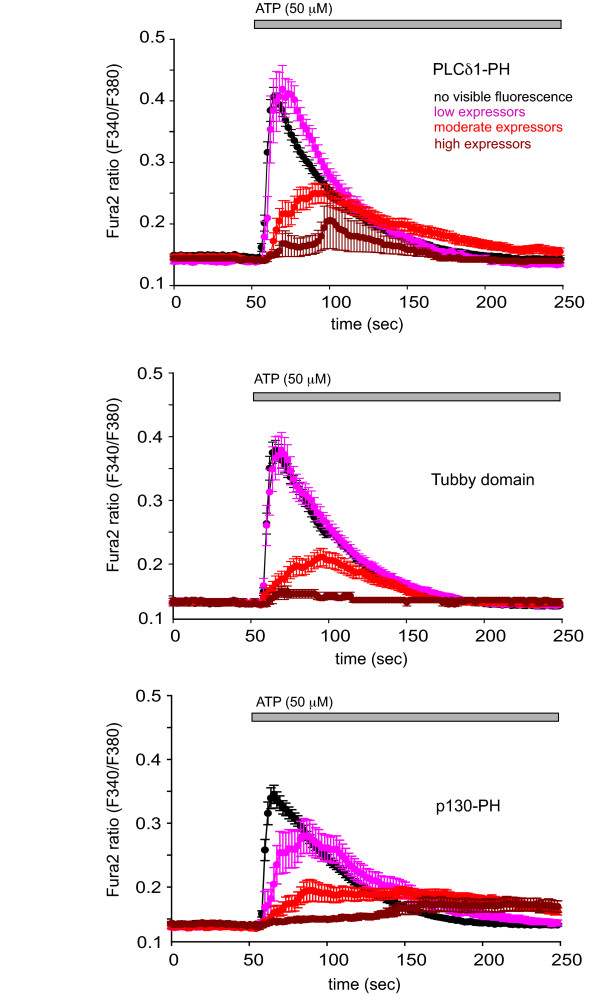
Inhibition of agonist-induced Ca2+ signaling by expressed mRFP-Tubby-domain, PLCδ1PH-mRFP and p130-PH-mRFP. COS-7 cells were transfected with the indicated mRFP fusion constructs, and their cytosolic Ca2+ responses were analyzed by ratiometric Ca2+ imaging using Fura2. The amount of fluorescent protein was determined after the release of all membrane bound constructs by the addition of high concentraction of ionomycin at the end of each experiment. ATP-induced Ca2+ responses were grouped into four categories according to expression levels of the red fluorescence and the responses were averaged (see Table 2 for these values in each group in arbitrary units). Note that each construct interferes with the Ca2+ signal in these COS-7 cells where the ATP-induced PLC activation and InsP3 increase is relatively modest. Such inhibitory effects are substantially smaller in HEK293-AT1 cells that show robust PLC activation (see Fig. 8). Table 2 shows the numerical values of the Ca2+ signaling parameters.